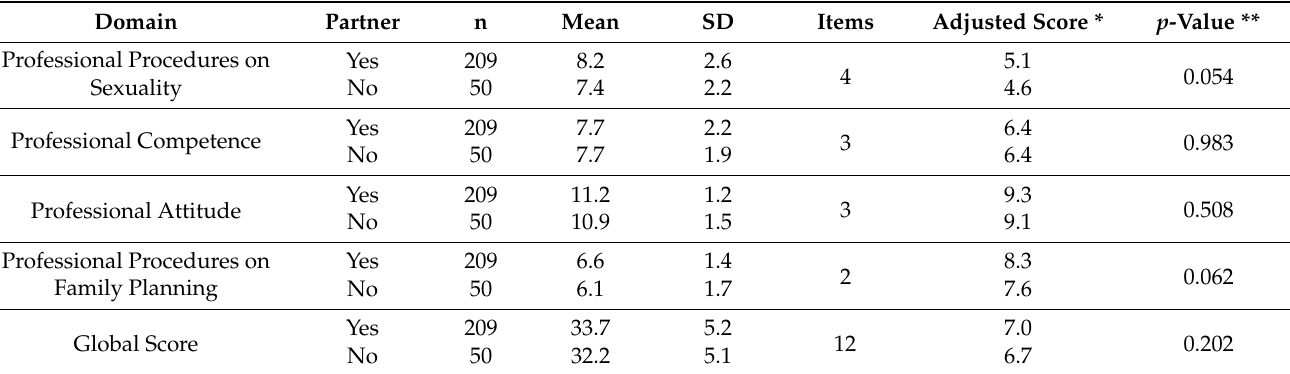
Table 12. Scores regarding if the participants had a